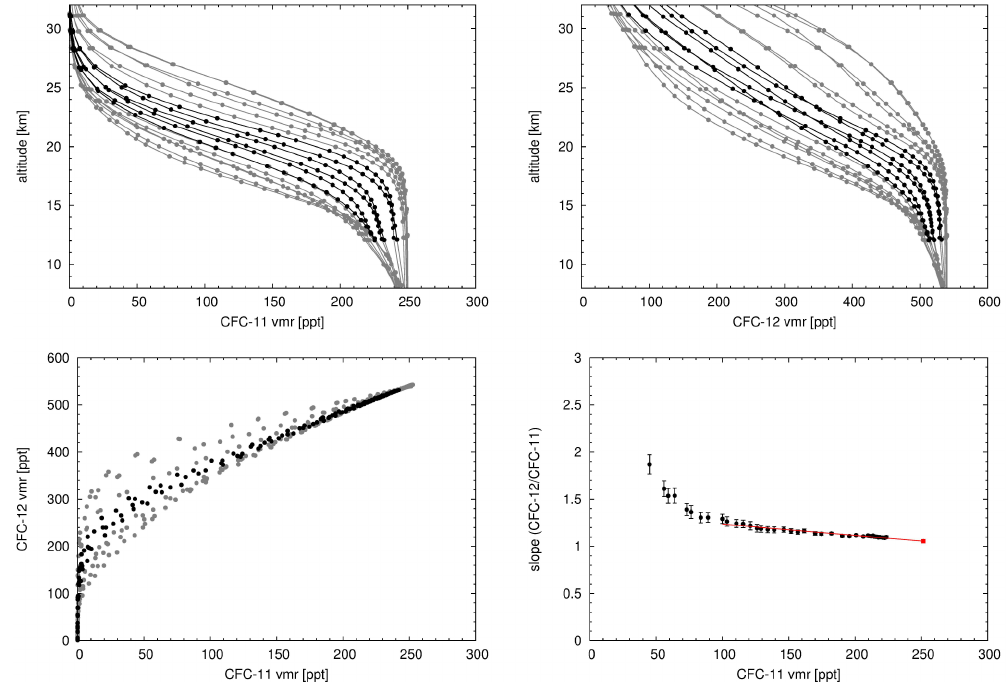
Figure 7. Same as Fig. 4, but for EMAC/CLaMS